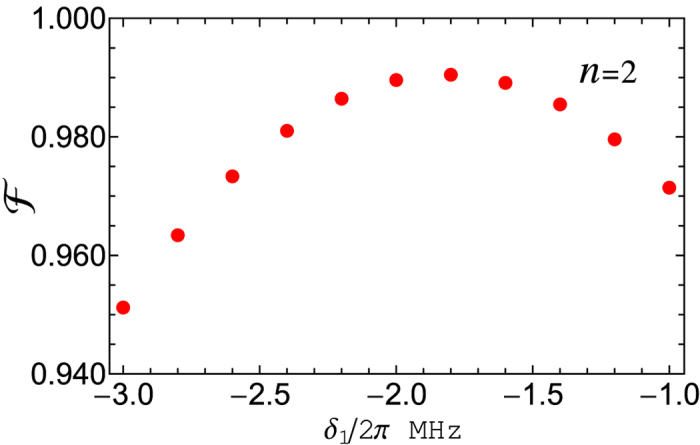
Fidelity versus δ1/2π, plotted for g12 = 0.01g1 and by taking the systematic dissipation and dephasing into account.The parameters used in the numerical simulation for Figs 6 and 7 are referred to the text.